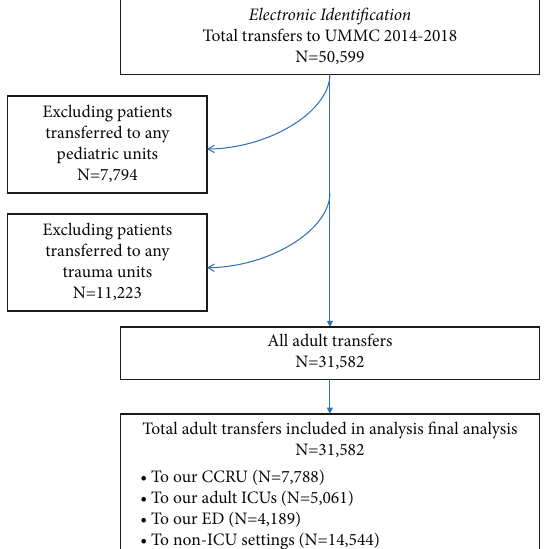
Figure 1: Flow diagram mapping patients included in the final analysis. Abbreviations: CCRU, critical care resuscitation unit; ED, emergency department; ICU, intensive care unit; UMMC, Uni- versity of Maryland Medical